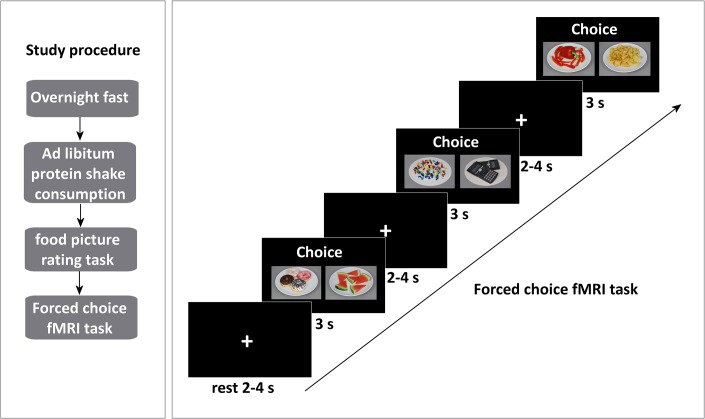
Study procedure & forced choice fMRI paradigm.